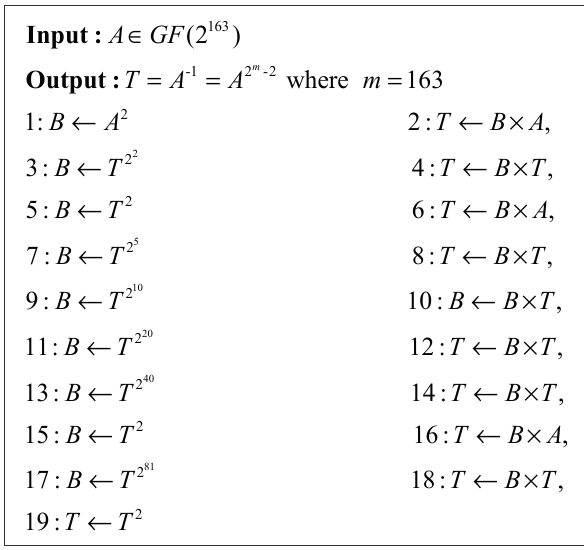
Algorithm 4. Inversion with IT method over GF (2 163